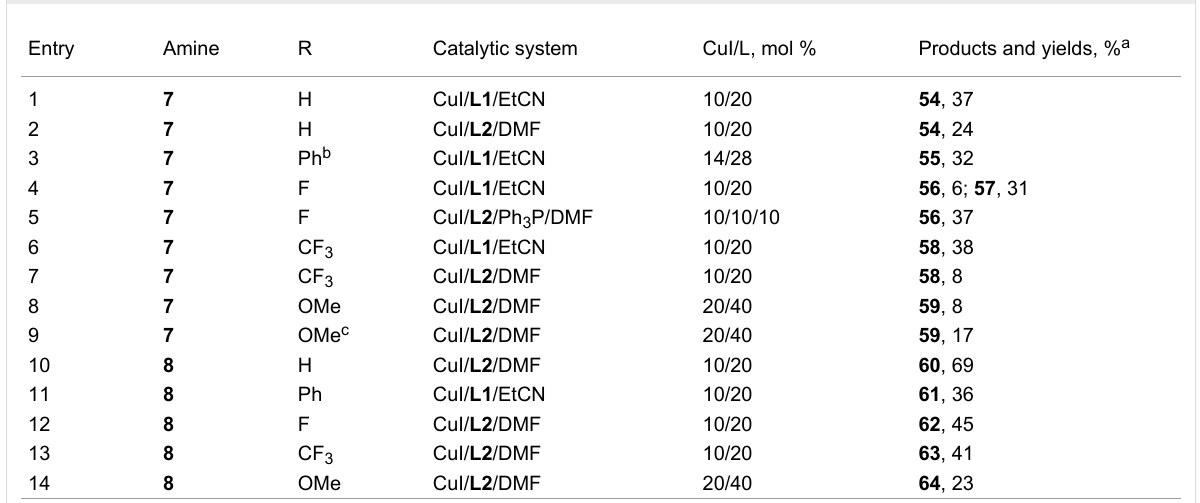
Table 5: Arylation of the tetraamines 7 and 8